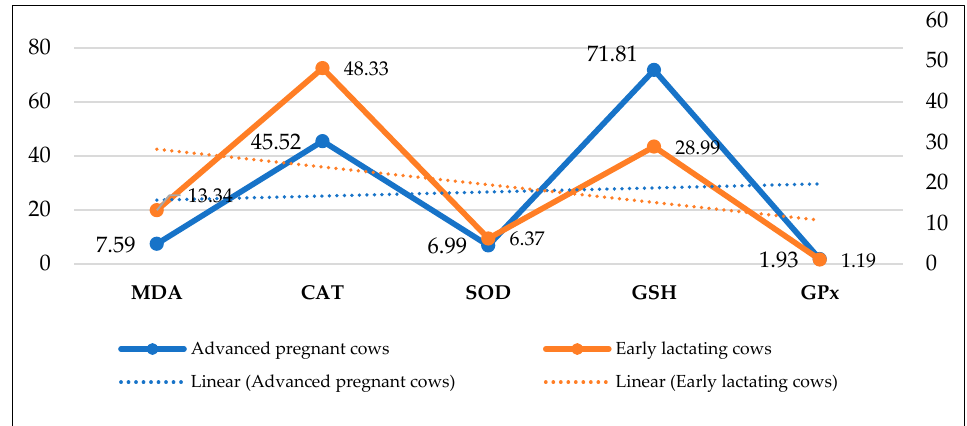
Figure 1. Oxidative stress and antioxidant status in advanced pregnant and early lactating dairy cows.